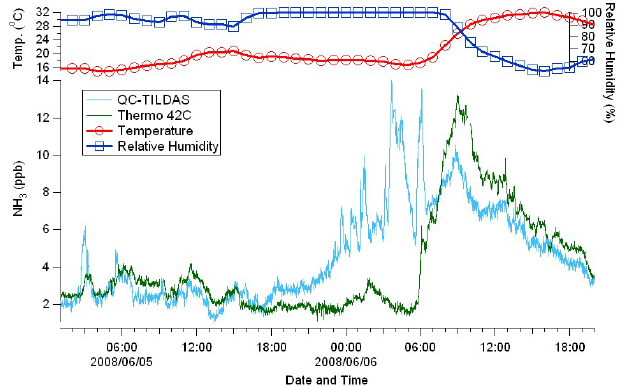
Fig. 7b. A period of rainfall and high relative humidity where the QC-TILDAS and Thermo 42CTL disagree for several hours may be due to condensation of water and uptake of NH 3 in the sampling lines of the Thermo 42CTL, followed by release of NH 3 the follow- ing morning when the temperature rose and the inlet dried.